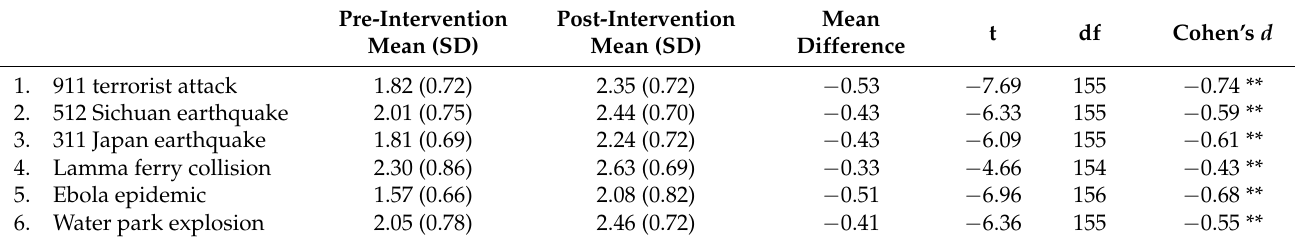
Table 3. Comparison between pre- and post-intervention for perceived ability.